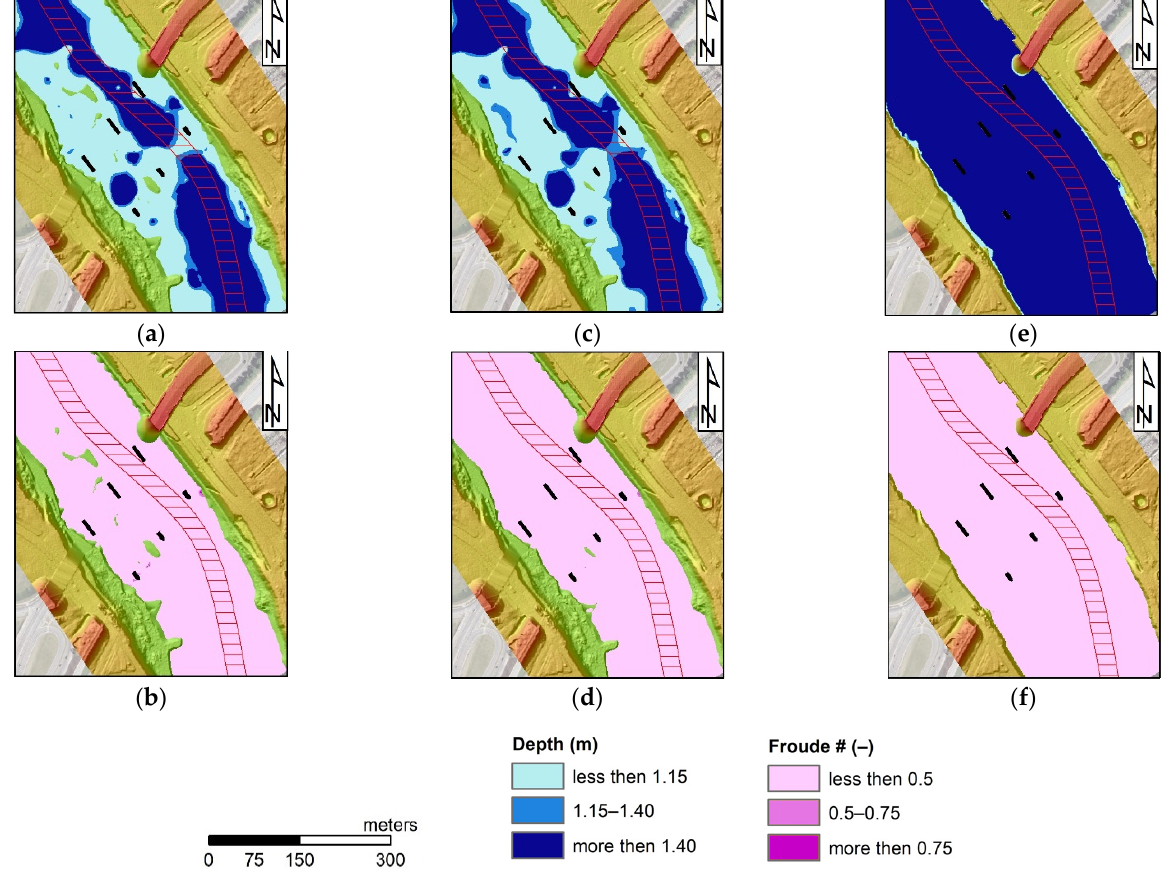
Figure 11. Results obtained for roughness of the bottom equal to 0.060 s m − 1/3 : ( a ) map of depth classes for Q 95% , ( b ) distribution of Froude # for Q 95% , ( c ) map of depth classes for Q 95% , ice, ( d ) distribution of Froude # for Q 95% , ice, ( e ) map of depth classes for Q 50% , ( f ) distribution of Froude # for Q 50% .